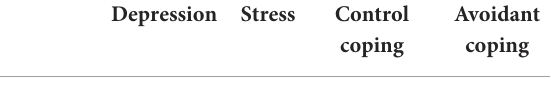
TABLE 2 Pearson’s correlation coefficients of work stress and job coping strategies (control, avoidant) on depression ( n =